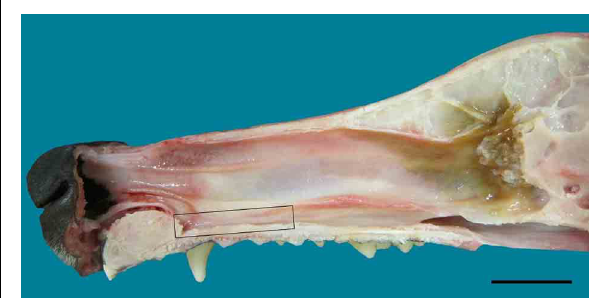
FIGURE 1 | Lateral view of the nasal septum of an adult dog, showing the difference in color between sensory (yellow-brown) and respiratory (red-orange) mucosa. The rectangle frames the vomeronarasal organ. Scale bar: 2cm (see Figure